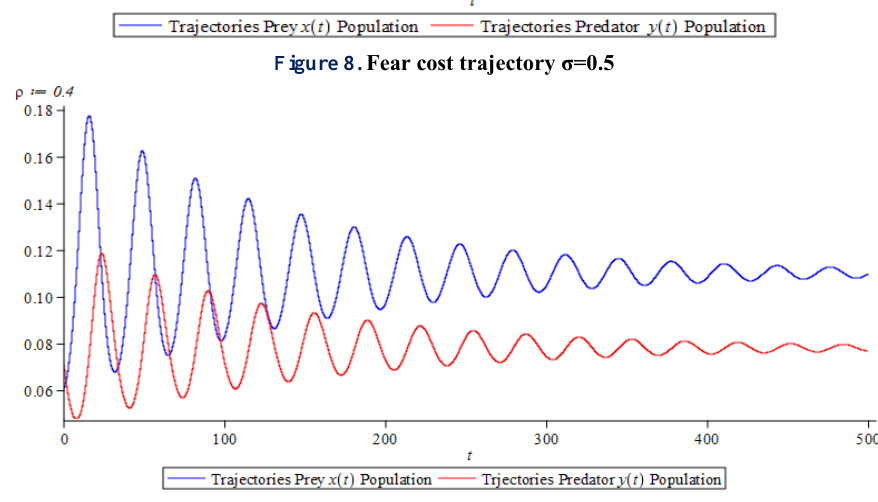
Figure 8. Fear cost trajectory σ=0.5